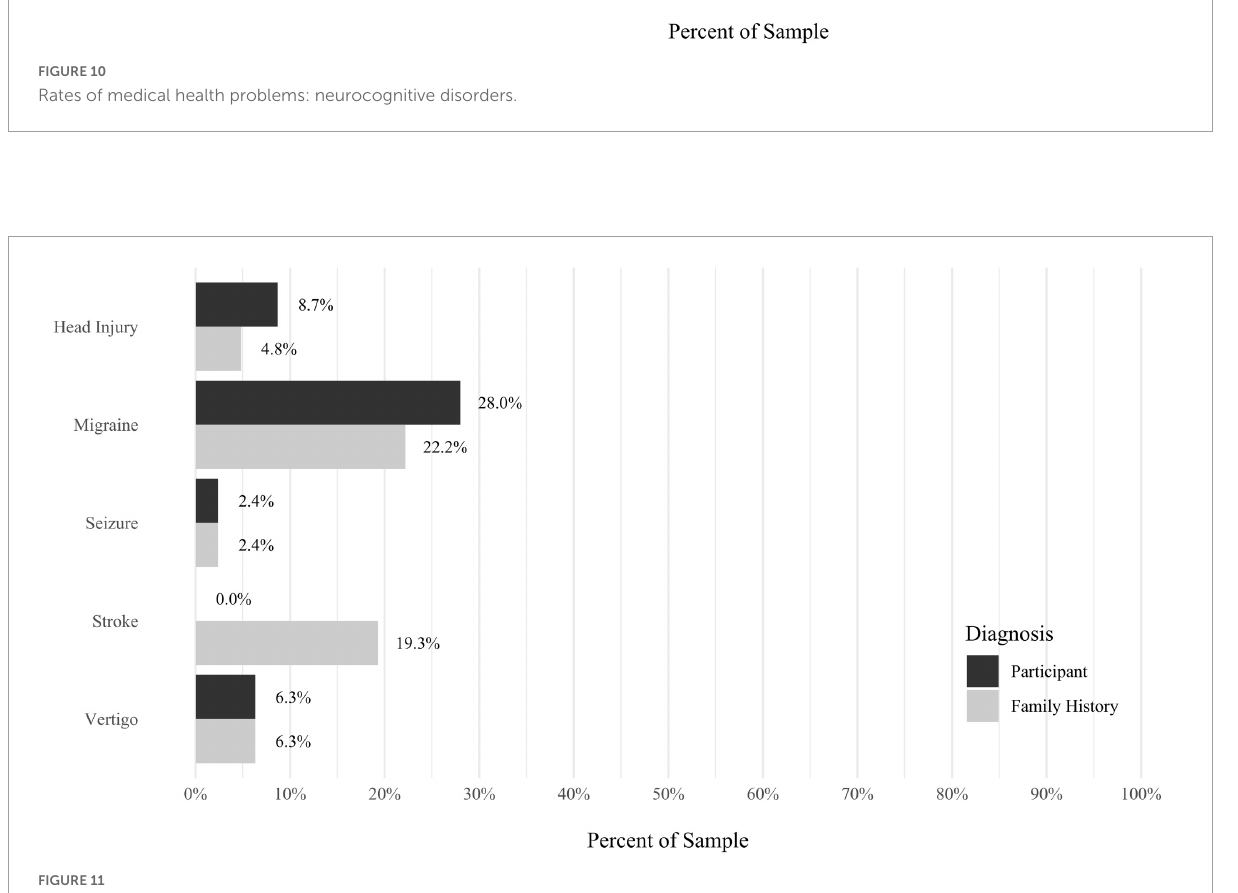
FIGURE11 Rates of medical health problems: neurological